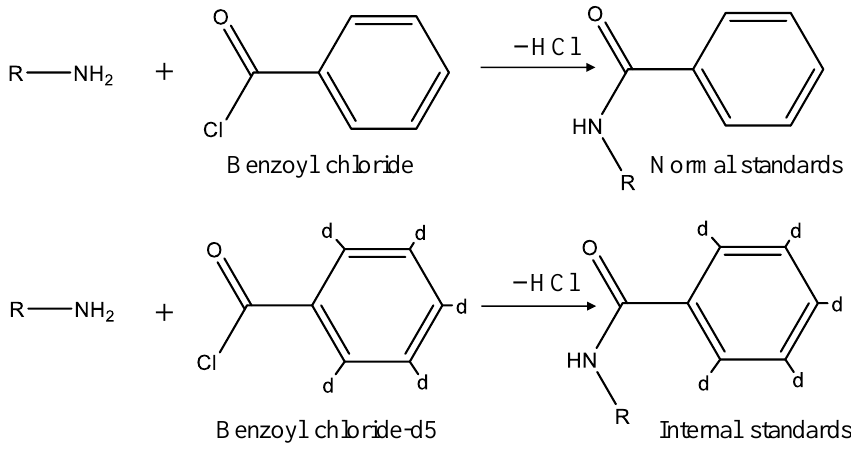
Figure 4. The derivatization scheme for BAs is derivatized by benzoyl chloride.